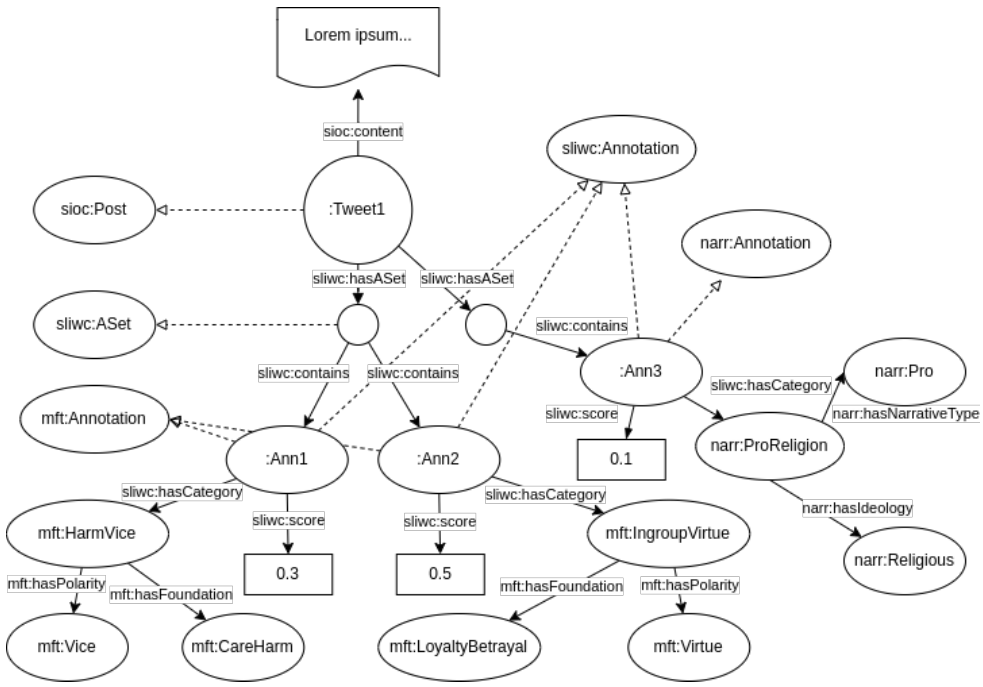
Figure 6. Example of LIWC-aligned annotations of a Tweet using the morality and narrative